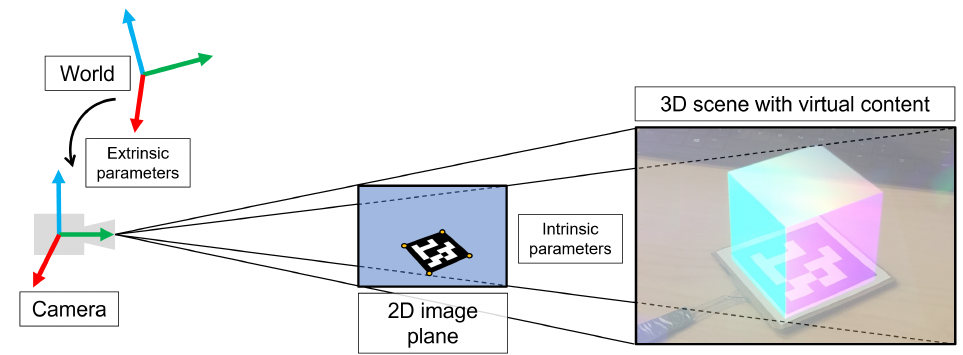
Figure 4. Depiction of the fundamentals of marker-based tracking. The intrinsic camera parameters serve to project three-dimensional (3D) content in the camera coordinate system to its two-dimensional (2D) representation on the camera image plane by perspective projection. The extrinsic parameters relate the position and orientation of the world coordinate frame to the camera coordinate frame. Combined, the intrinsic and extrinsic camera parameters allow the relation of 3D points in the world to 2D points on the camera image plane and enable marker-based tracking and precise augmentation of virtual